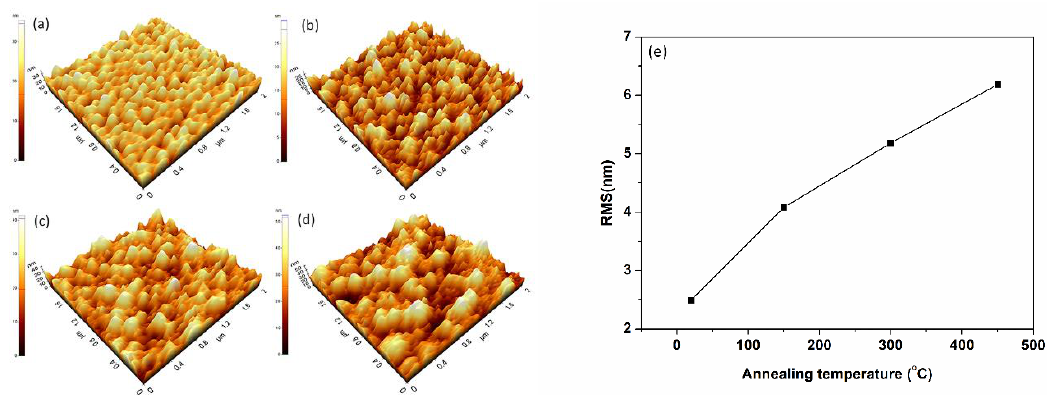
Figure 2. ( a – d ) AFM surface morphology patterns of ITO films before and after annealing. ( a ) for S0 (as deposited), ( b ) for S1, ( c ) for S2, and ( d ) for S3. ( e ) RMS values of ITO film annealing in different temperatures.